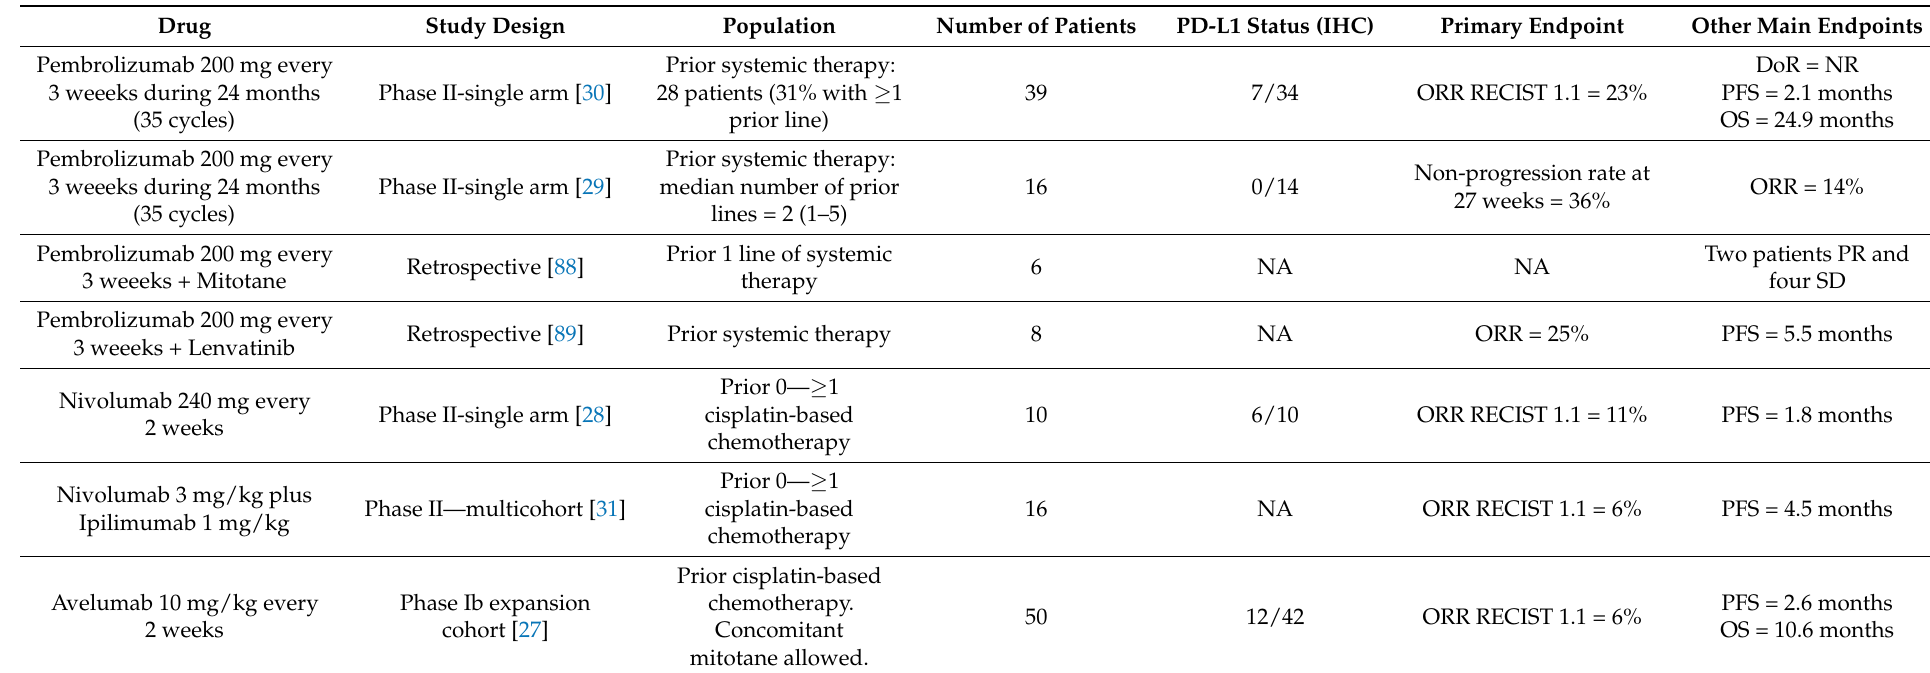
Table 2. Summary of studies that have investigated immunotherapy in patients with adrenocortical